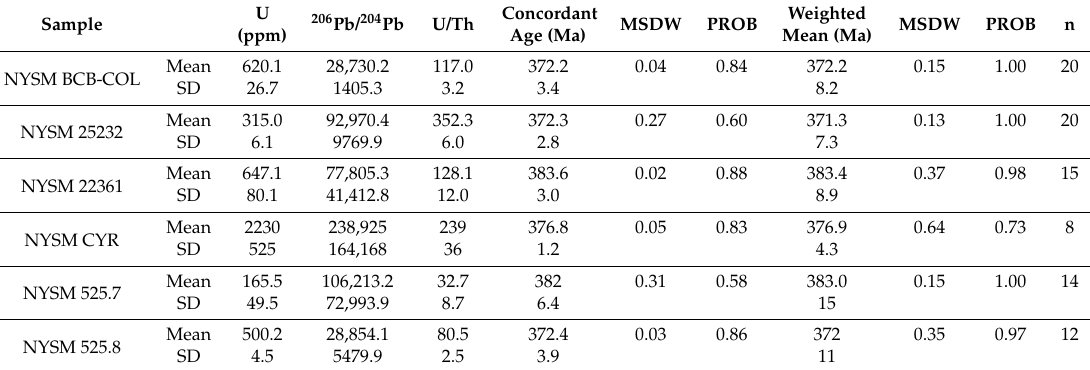
Table 4. Summary of the U-Pb columbite/cyrtolite geochronological